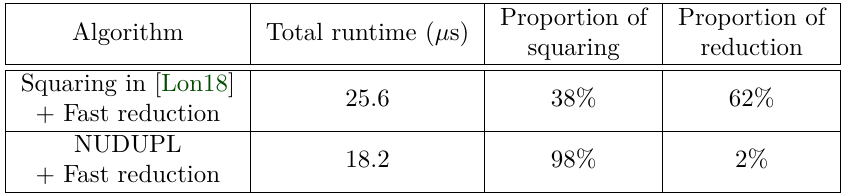
Table 5: The software runtime for two squaring algorithms.